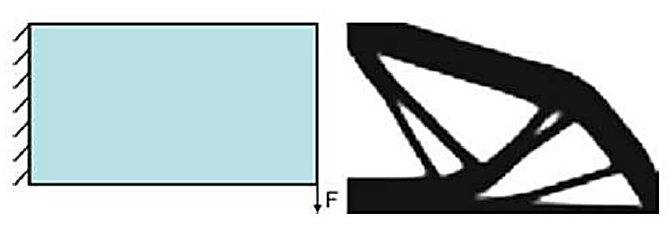
Figure 4. Typical optimization problem